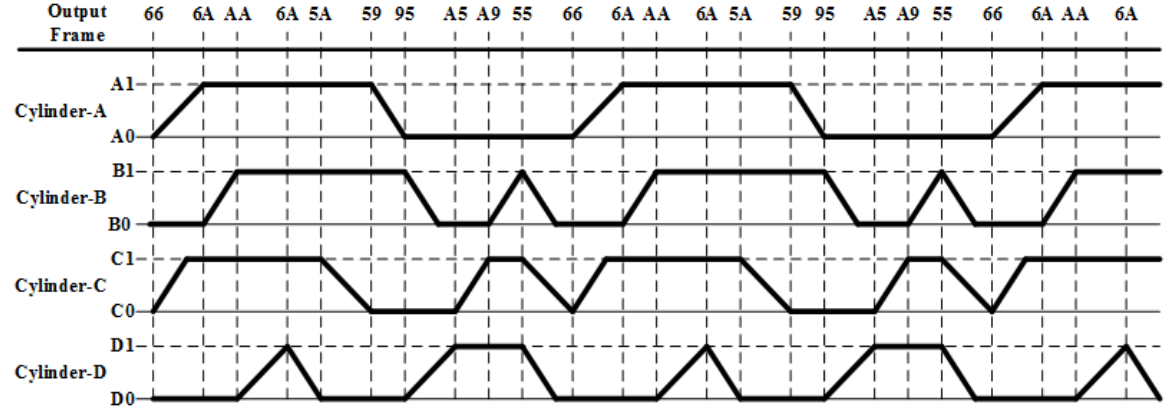
Fig. 9. Step Time Diagram of Experimental